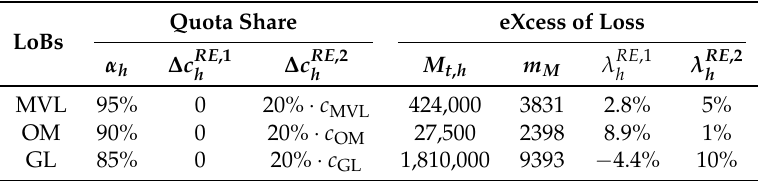
Table 4. Parameters of reinsurance strategies.